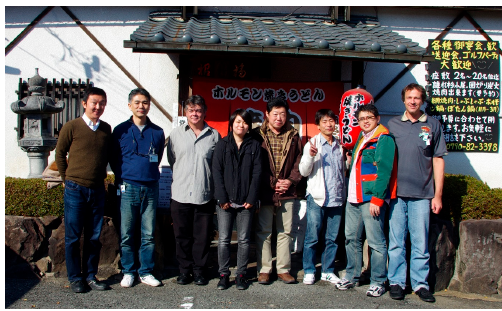
Figure 11. The experimentalists: support staff, Shuoyuan Zhang, and some of the authors, Koichi Akita, Mark Reid, Ayumi Shiro, Ken-ichi Funakoshi, Takahisa Shobu, Hiroshi Suzuki and Klaus-Dieter